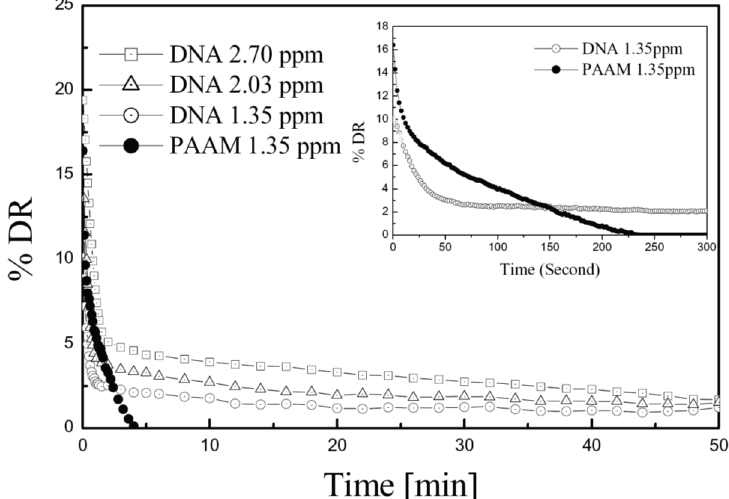
Figure 12. Comparison of λ -DNA percent drag reduction (1.35, 2.03, and 2.70 wppm) with PAAM ( M w) 18 × 10 6 g/mol) on long-term scale (1 h) at 1980 rpm ( N Re ) 1 × 10 6 ) and 25 °C. The inset represents the initial changes in the drag reducing efficiency for λ -DNA and PAAM at 1.35 wppm (Reprinted from [61]).